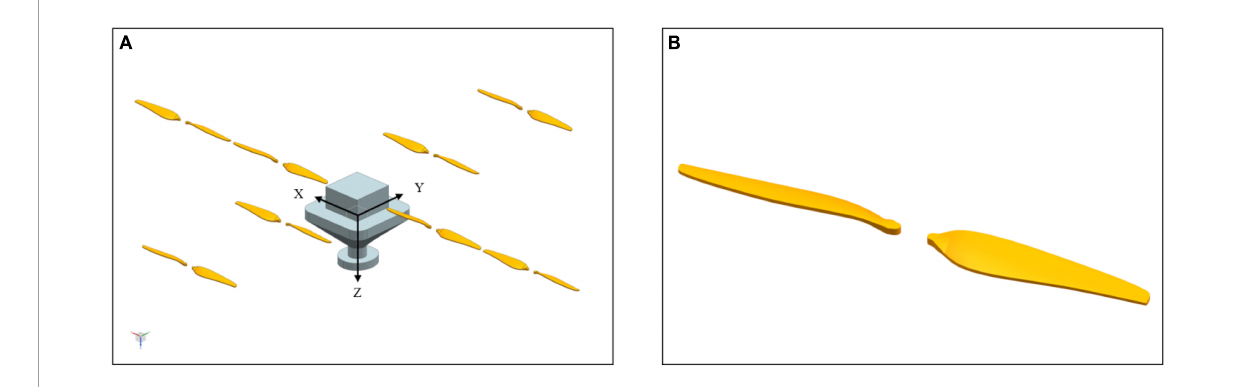
FIGURE3 The simplified structure for numerical simulation processes. (A) Represents the simplified rotor and other structures, while (B) represents the specific structure of each propeller after simplification.